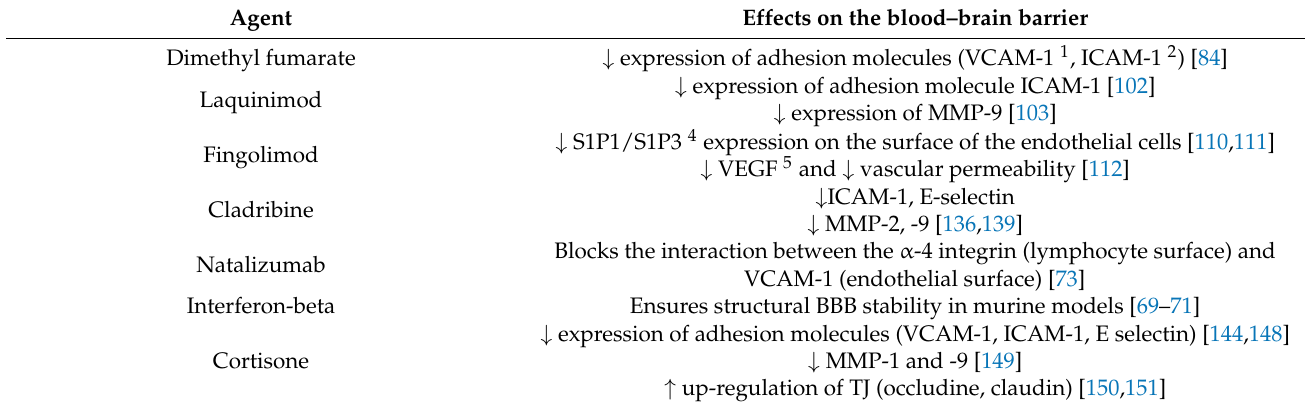
Table 1. Effects on